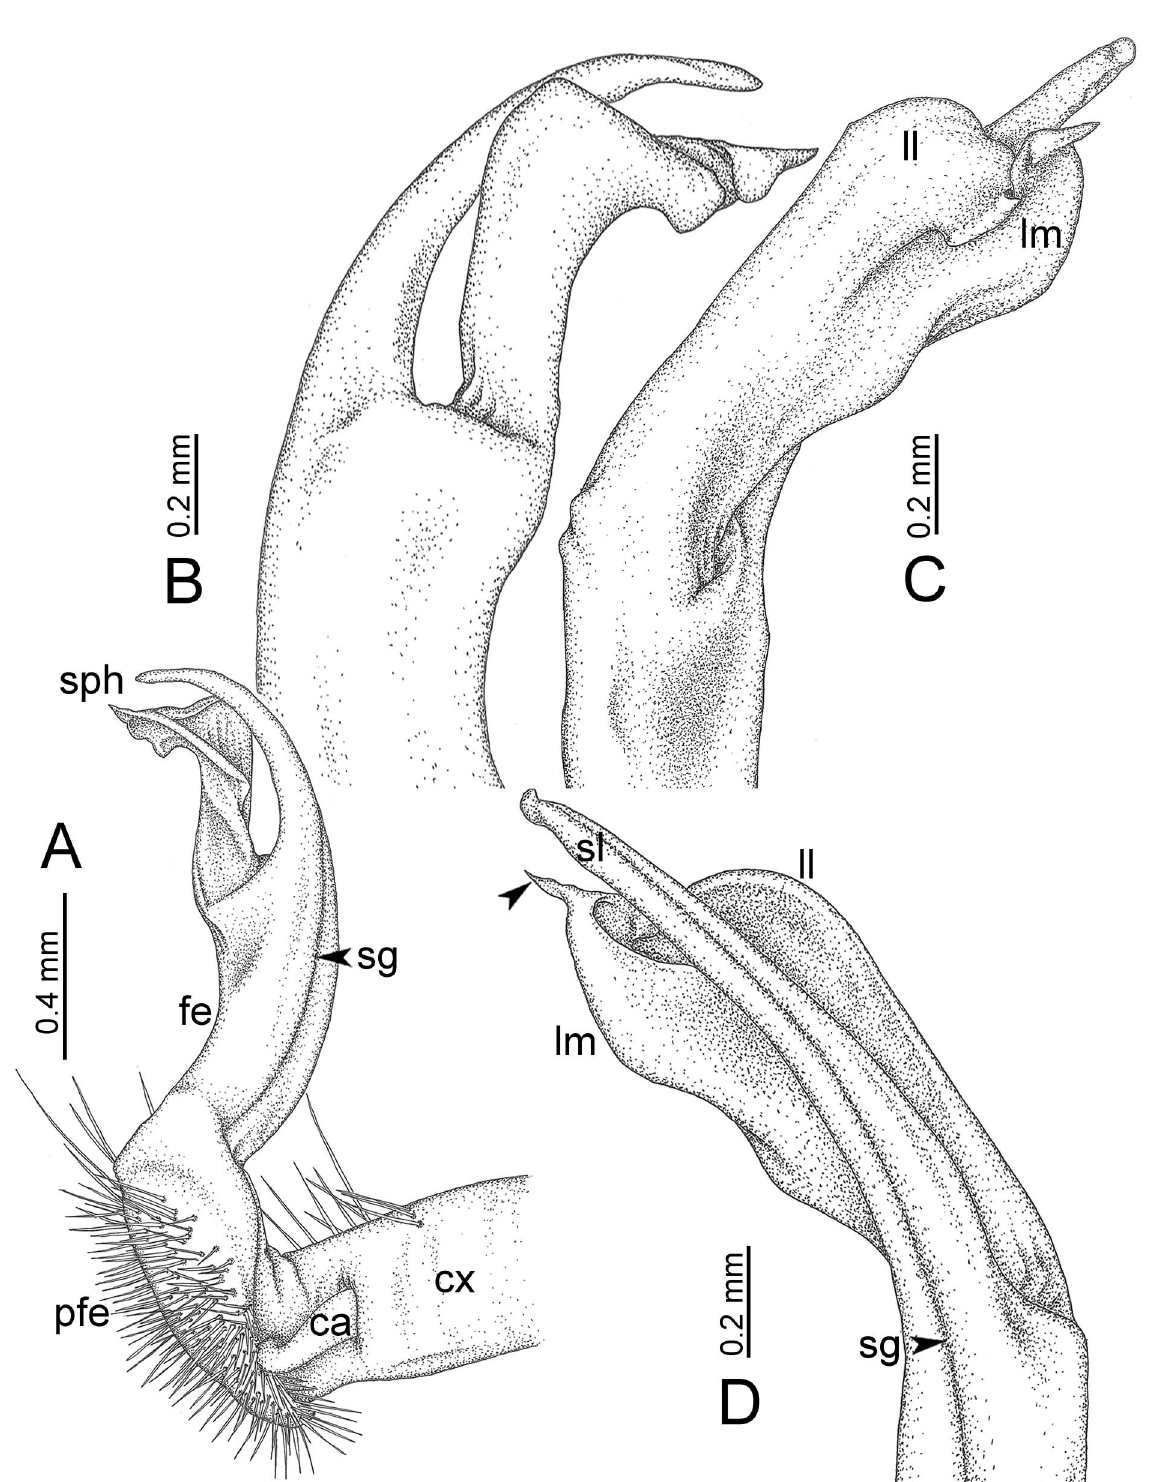
Fig. 7. Gigaxytes fusca Srisonchai , Enghoff & Panha gen. et sp. nov., ♂ paratype – right gonopod. A . Mesal view. B . Lateral view. C . Ventral view. D . Dorsal view (arrowead points to sharp tip of lamina